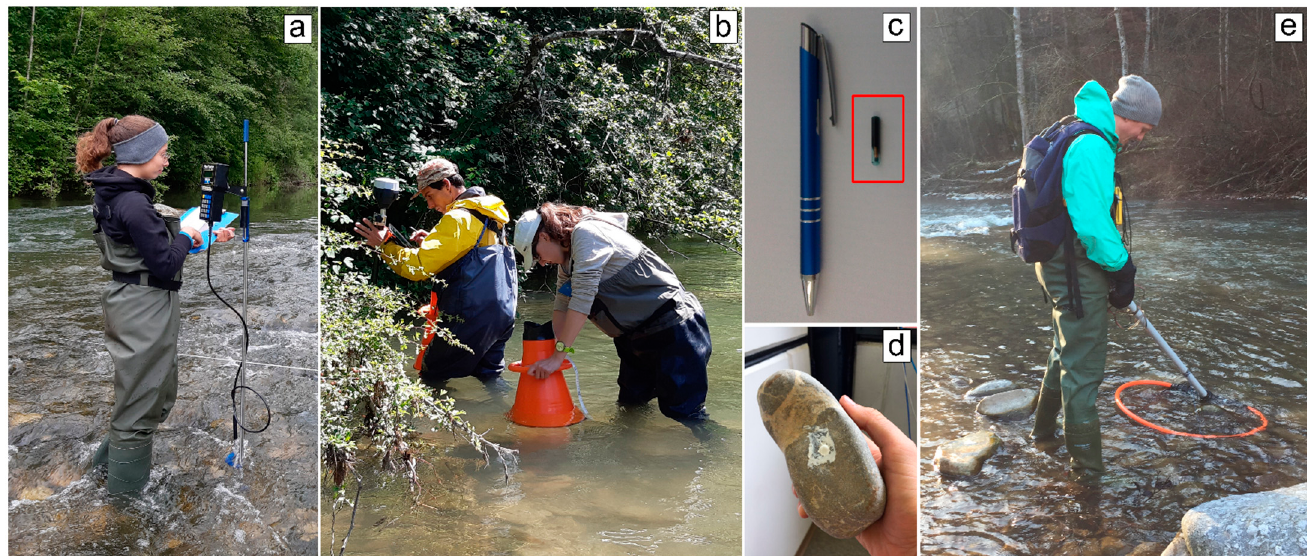
Figure 4. Assessment of the eco-morphological effectiveness of a sediment augmentation measure: ( a ) recording flow velocities and water depth along fixed cross-sections, for the calculation of the HMID abiotic indicator; ( b ) mapping substrate quality for the calculation of the IRS [113] abiotic indicator; ( c ) RFID-pit sensor; ( d ) a pebble with an RFID-pit sensor inside; ( e ) post-flood bedload tracing, searching for the RFID-pit sensor pebble with a mobile antenna.